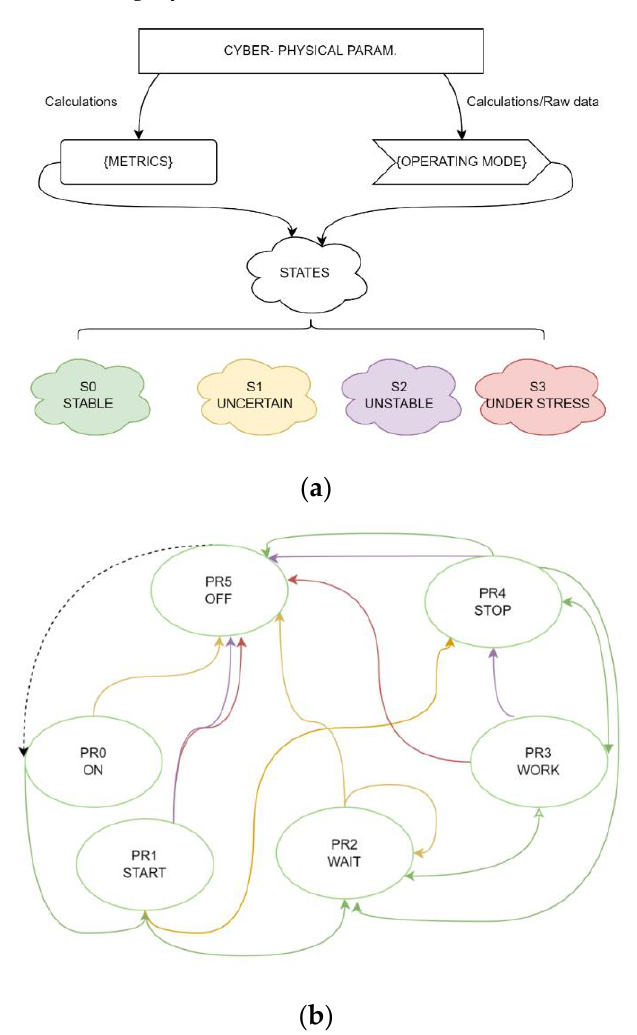
Figure 3. Scheme of conditions for transitions from one control process to another: ( a ) relationship between states and cyber - physical parameters, and ( b ) transitions from processes with the state’s consideration.